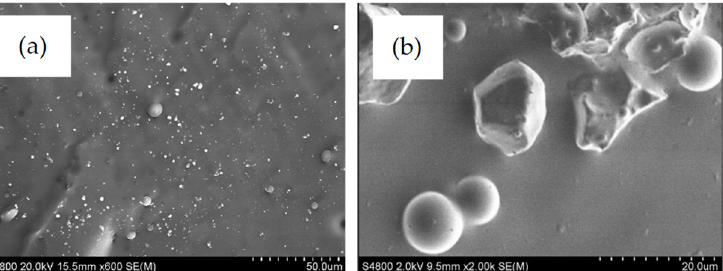
Figure 9. SEM image of ( a ) ×600 and ( b ) ×2k of PDMS/PU (95:5) with 3 wt.% SiO 2 composites. Table 2. EDX analysis results including weight and atomic percentage of various elements found on the surface of the materials.